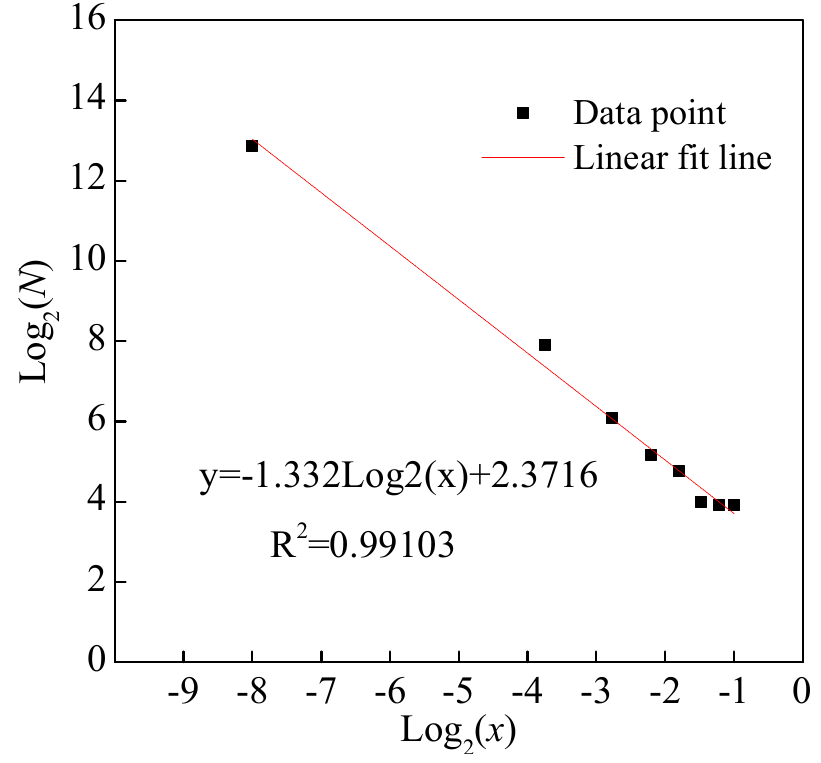
Figure 4. A typical example used to calculate fractal dimensions.